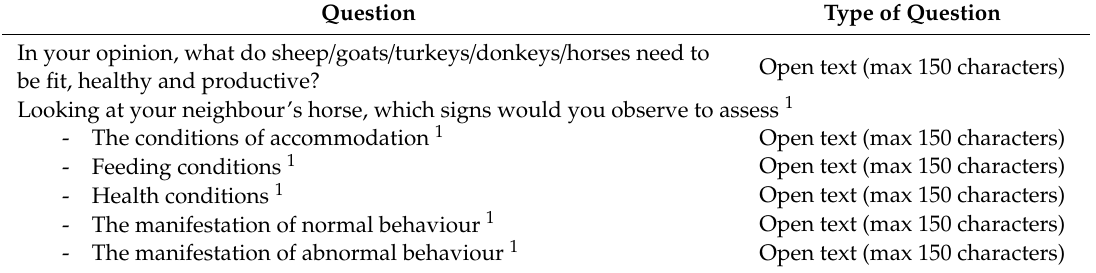
Table 1. List of the questions selected from the questionnaire whose results are reported in the manuscript. Question Type of Question In your opinion, what do sheep / goats / turkeys / donkeys / horses need to be fit, healthy and productive? Looking at your neighbour’s horse, which signs would you observe to assess